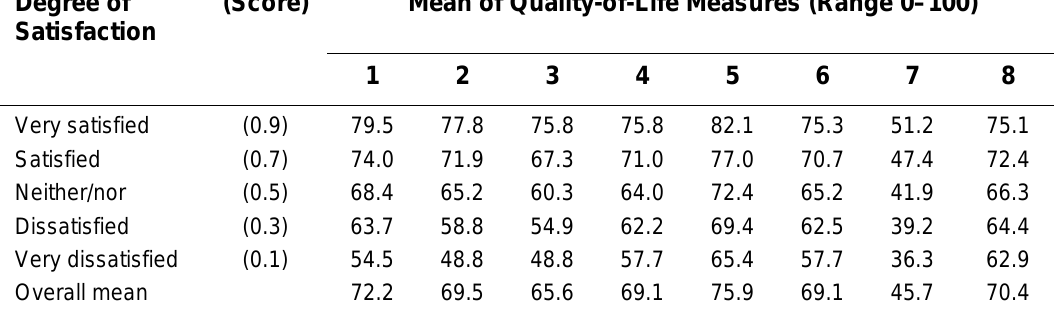
Degree of Satisfaction with Sex Life (Data from a Reference Sample of Danes, n = 1,397)